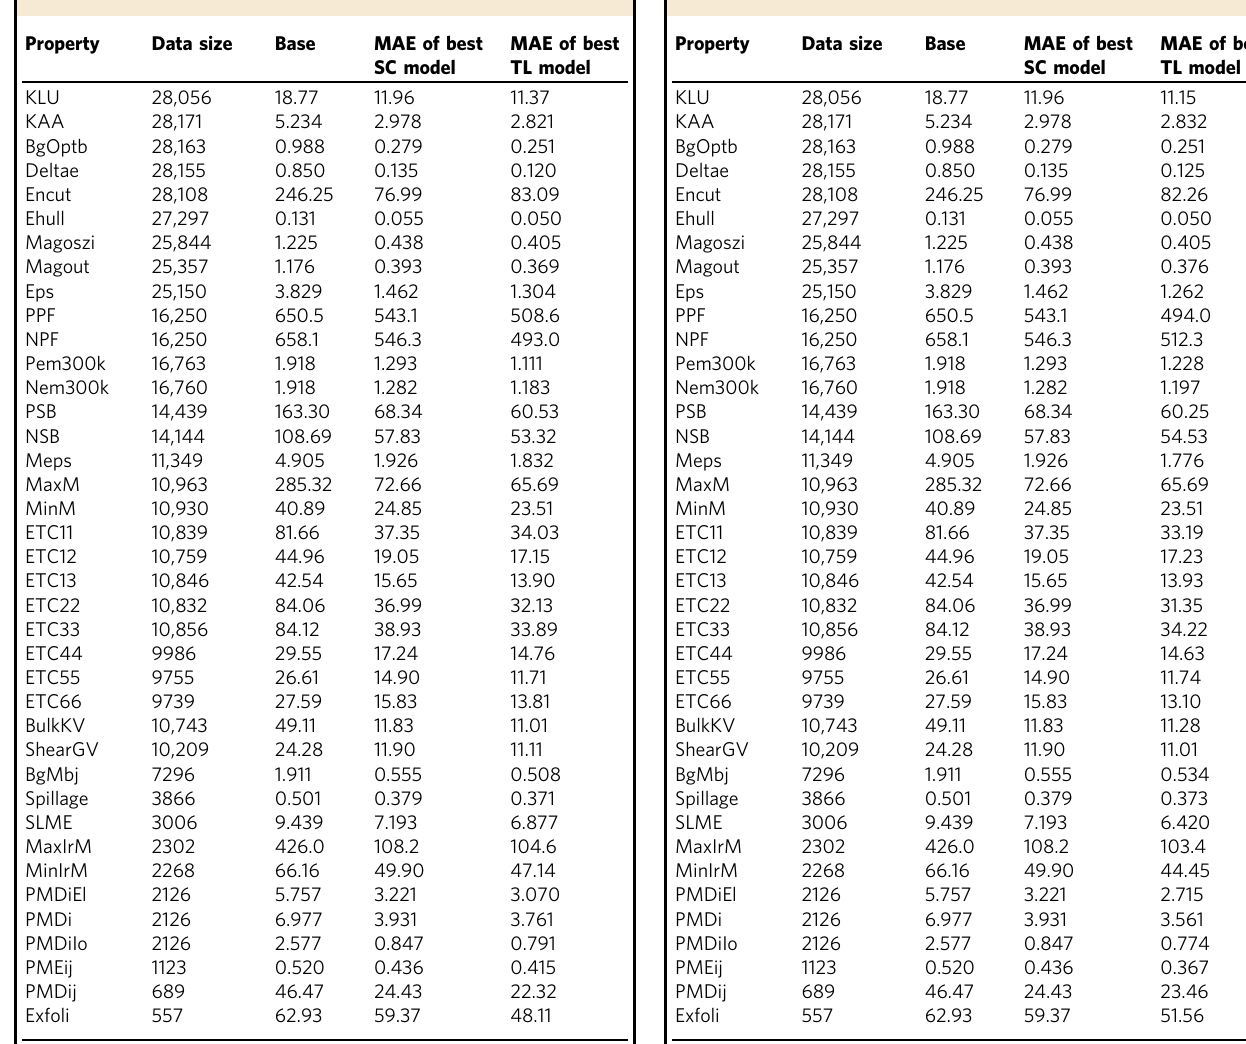
Table 3 Prediction performance benchmarking for the prediction task of “ Multi Source Transfer Learning" on the test set.